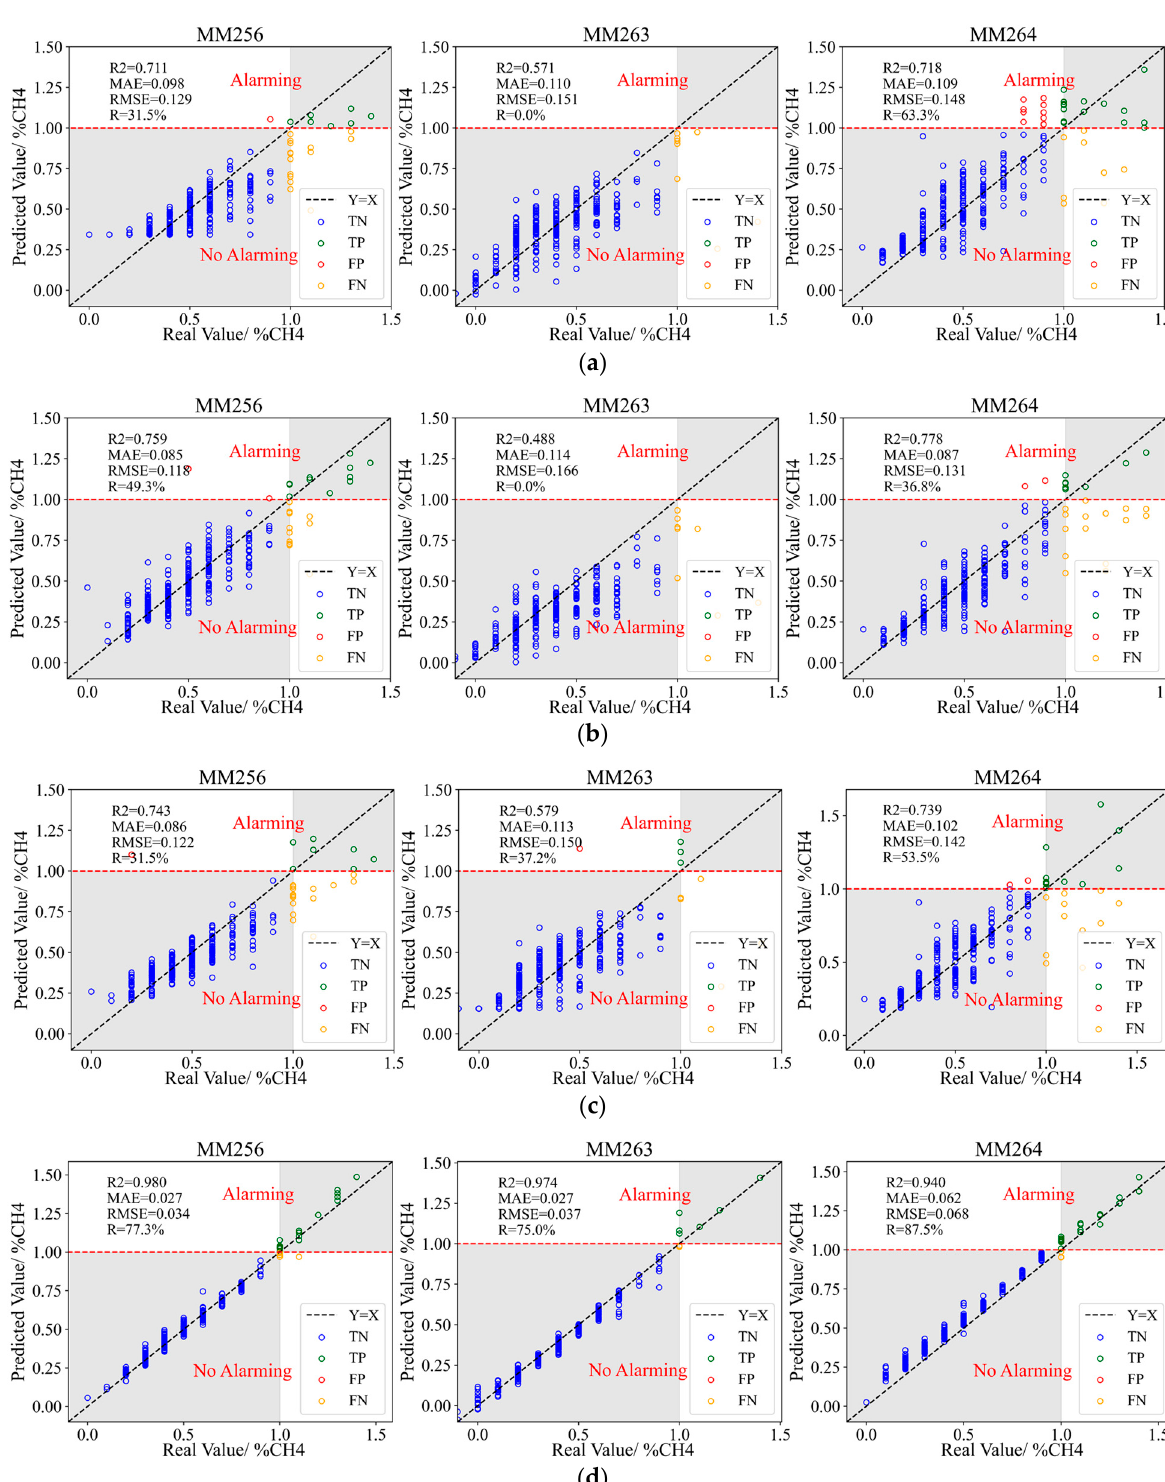
Figure 14. Prediction results of different indicators models. ( a ) Bi-LSTM single indicator model. ( b ) Bi-LSTMs all-indicators combined model. ( c ) Bi-LSTMs specified indicators combined model. ( d ) Bi-LSTMs dynamic optimized indicators combined model.